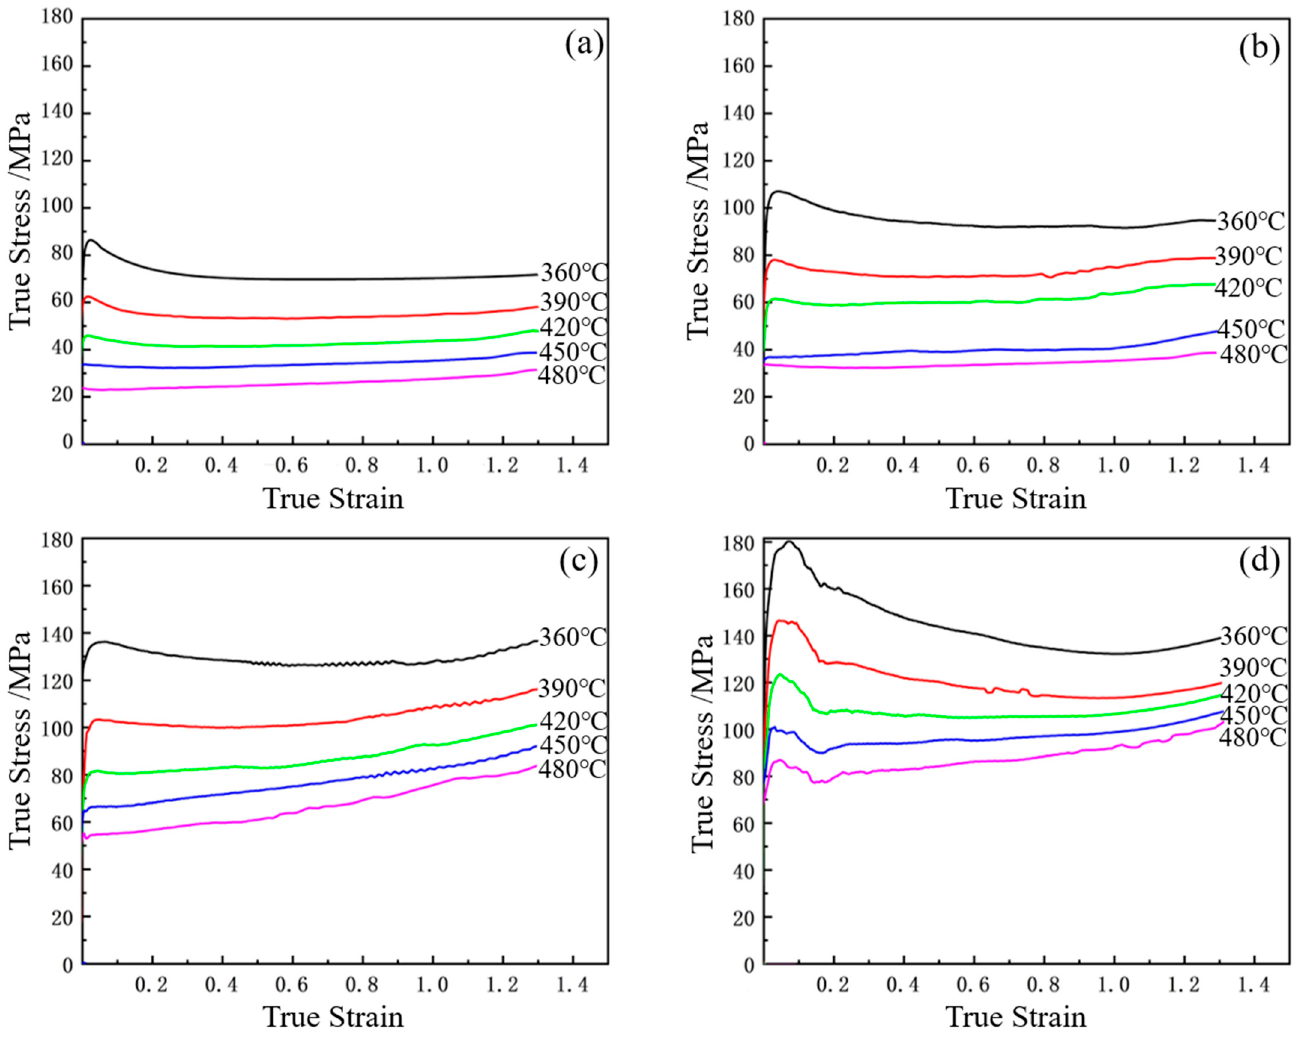
Figure 4. True stress–true strain curves for hot compression deformation of HG AA2195 Al-Li alloy at different temperatures and strain rates: ( a ) 0.01 s − 1 , ( b ) 0. 1 s − 1 , ( c ) 1 s − 1 , ( d ) 10 s − 1 .